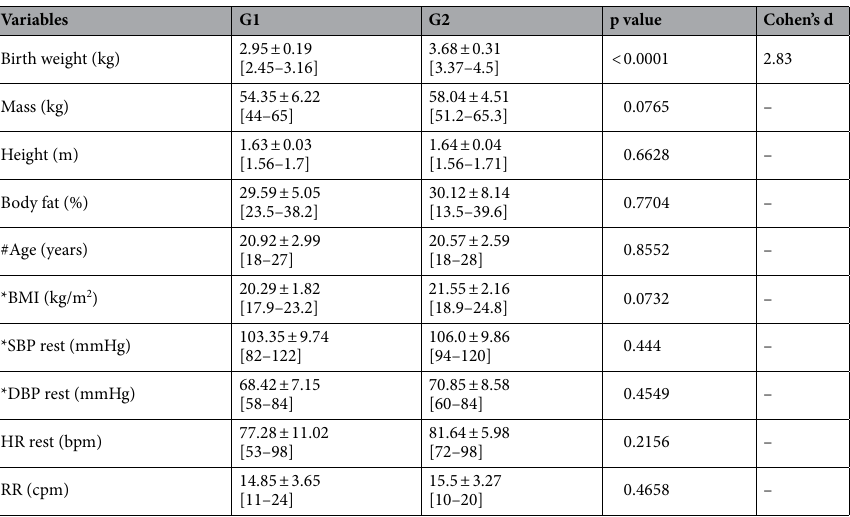
Table 1. Characterization of the sample regarding age, birth weight, mass, height, body fat, BMI, resting HR, RR, SBP and DBP. Mean ± standard deviation [minimum–maximum]. Average values followed by their